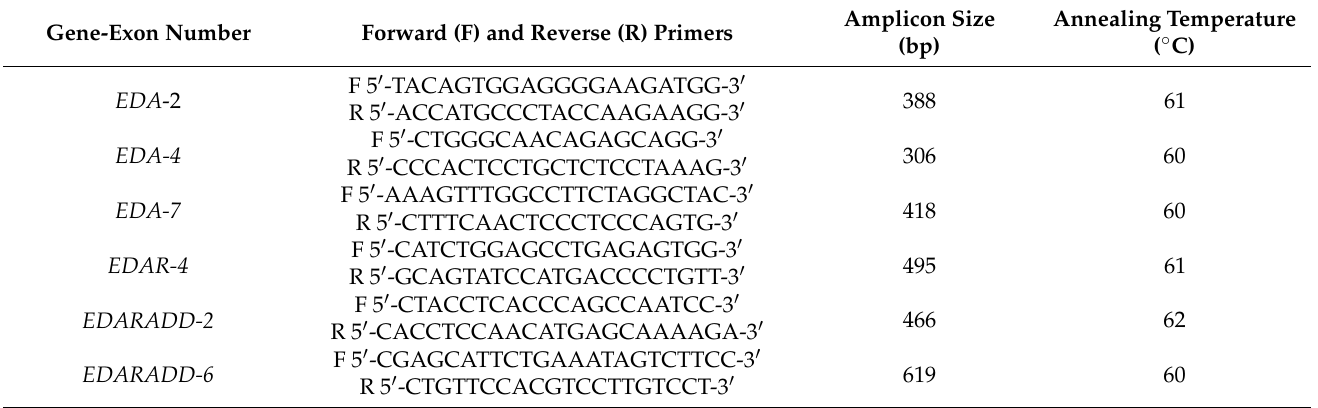
Table 1. Primers Used for Amplification of Targeted Exons of EDA , EDAR and EDARADD Genes. Gene-Exon Number Forward (F) and Reverse (R)